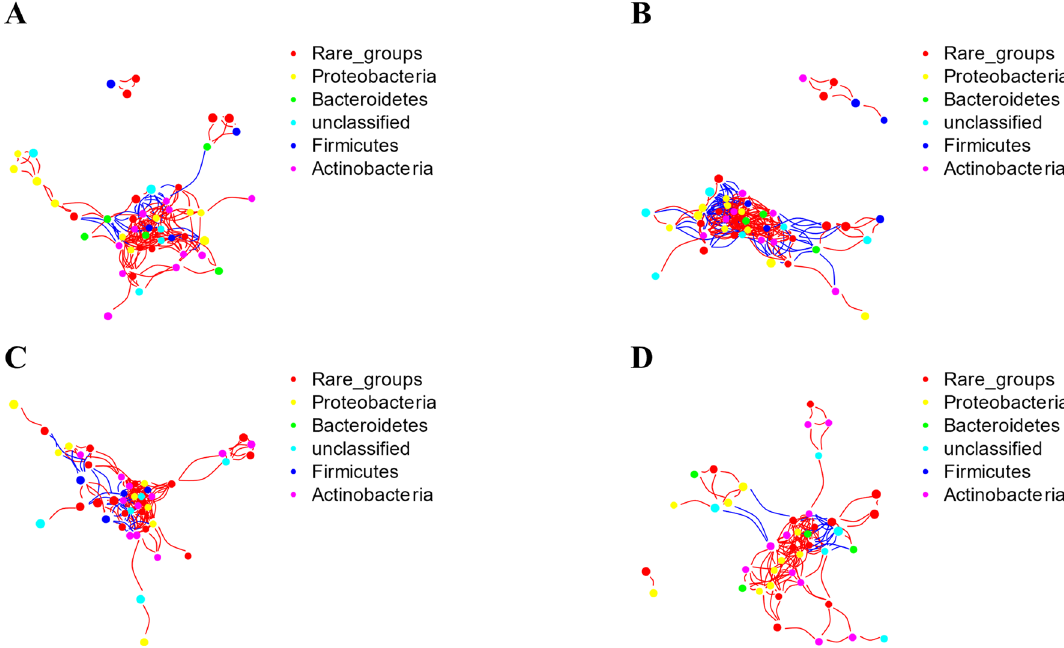
Figure 6. Bacterial coexpression network analysis of healthy wheat and inoculated wheat of resistant and susceptible wheat varieties. ( A ) Coexpression network of inoculated resistant wheat. ( B ) Coexpression network of healthy resistant wheat. ( C ) Coexpression network of inoculated susceptible wheat. ( D ) Healthy susceptible wheat coexpression network. Positive interactions are depicted as red edges, and the negative interactions are depicted as blue edges. Descriptive and topological network properties were performed with the R package igraph 44 . The co-occurrence networks were using the “Fruchterman-Reingold” layout with 10 4 permutations in igraph 45